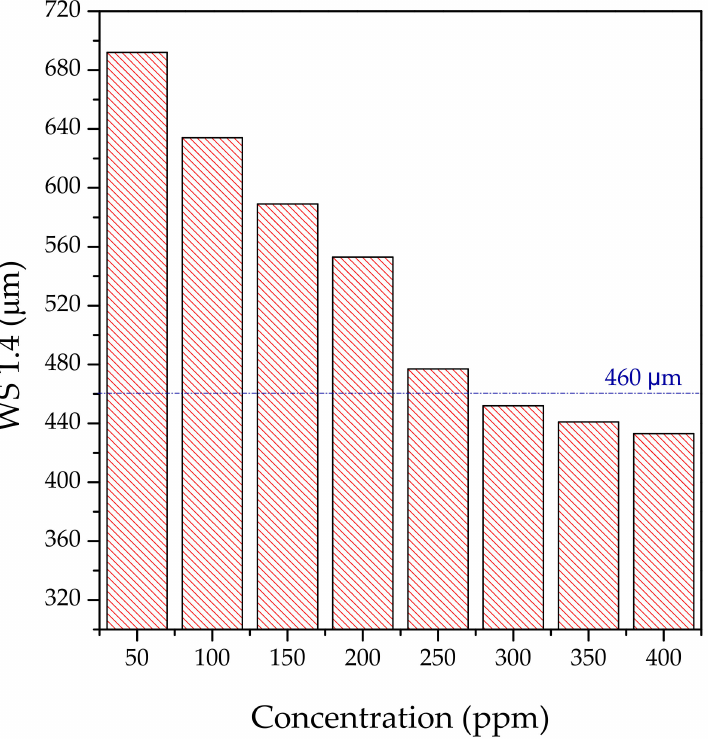
Figure 2. Impact of sunflower oil N , N -Bis(2-ethoxyethyl) amides addition on the lubrication charac- teristics of the base fuel.